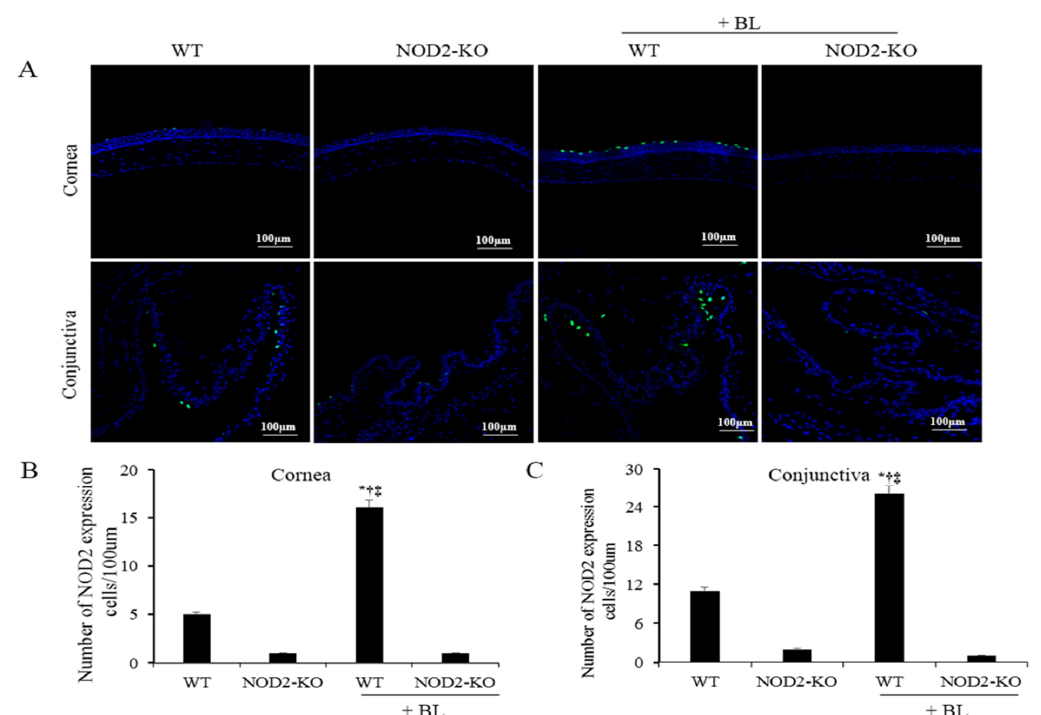
Figure 2. Immunofluorescent staining of representative photograph ( A ) and the mean number of NOD2 expression in corneal ( B ) and conjunctival ( C ) tissues of the WT, NOD2-KO, WT+BL, and NOD2-KO+BL groups, after 10 days of blue light exposure. * p < 0.05 vs. WT; † p < 0.05 vs. NOD2-KO ‡ p < 0.05 vs. WT + BL; WT, wild type; BL, blue light; NOD2-KO, nucleotide-binding oligomerization domain 2 knock-out.